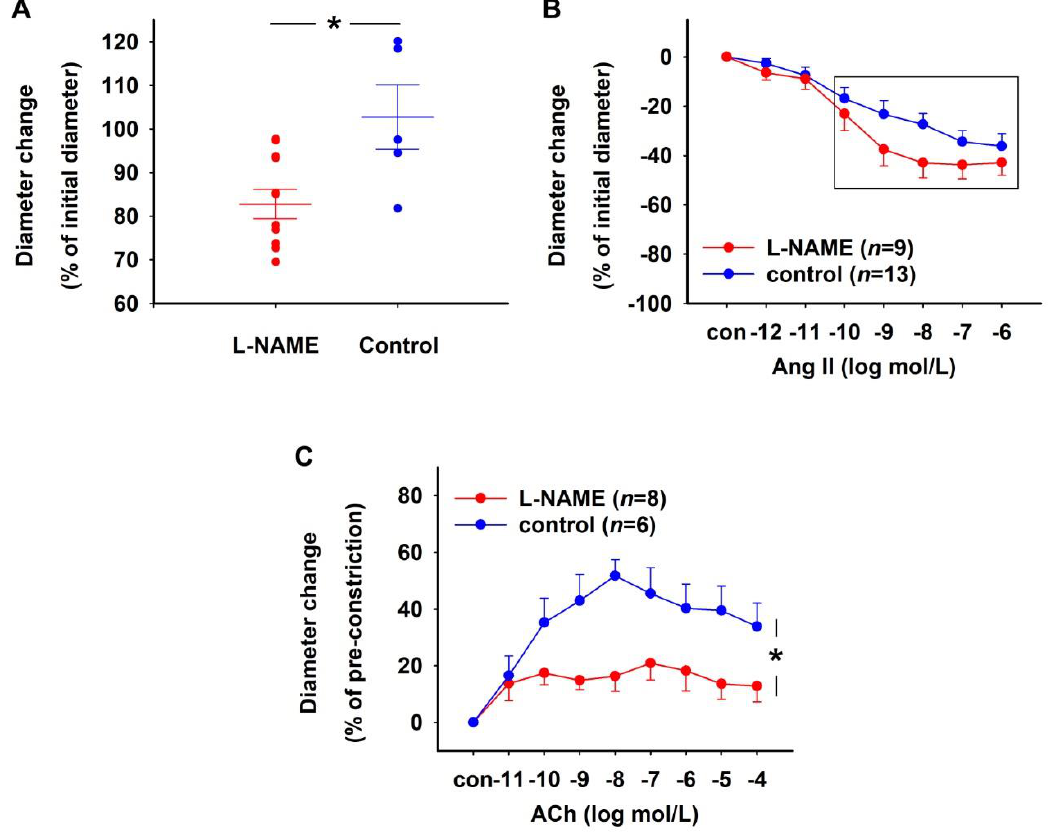
Figure 1. Effect of L-NAME on rat DVR. ( A ) Vessels treated with L-NAME (10 − 4 mol/L) for 15 min ( n = 12) showed significant constriction compared to untreated control ( n = 5) vessels (Mann–Whitney test, * p < 0.05). Vessel diameters in both groups before treatment were not significantly different (mean ± SEM: 8.48 ± 0.84 µ m (L-NAME) vs. 7.84 ± 0.83 µ m (control), Mann–Whitney test, p > 0.05). ( B ) Concentration–response curves showing the constriction induced by Ang II in DVR with and without 10 −4 mol/L L-NAME pre-treatment for 15 min. L-NAME-treated DVR constricted signifi- cantly more in response to higher Ang II concentrations (highlighted in a box) than the control group (Brunner test, * p < 0.001). ( C ) Concentration–response curves showing the relaxation induced by 10 − 11 –10 − 4 mol/L acetylcholine (ACh) in DVR with and without pre-treatment with 10 − 4 mol/L L-NAME for 15 min. L-NAME-treated vessels showed a lower maximum response to ACh compared to the control group (Brunner test, * p < 0.01).